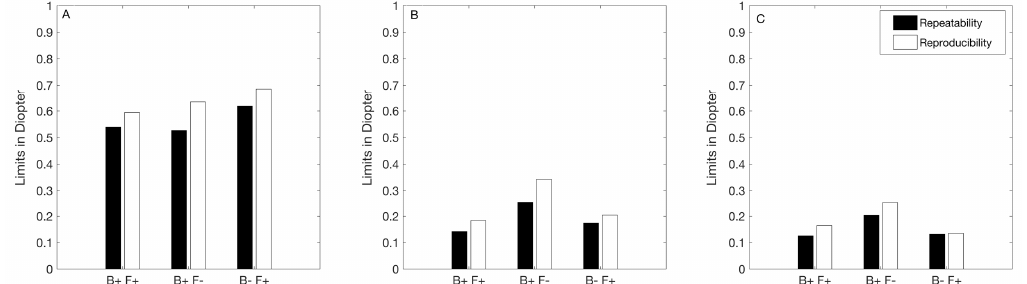
Figure 1. Repeatability and reproducibility limits of objective refraction measurement with the three instruments. The repeatability and reproducibility limits were calculated as 1.96 ∙ √2 ∙ where Sw is the within subject standard deviation. ( A ) spherical equivalent, ( B ) cylindrical vector J0, ( C ) cylindrical vectors J45. B + F + : binocular instrument with fogging, B + F − : binocular instrument without fogging, and B − F + : monocular instrument with fogging.